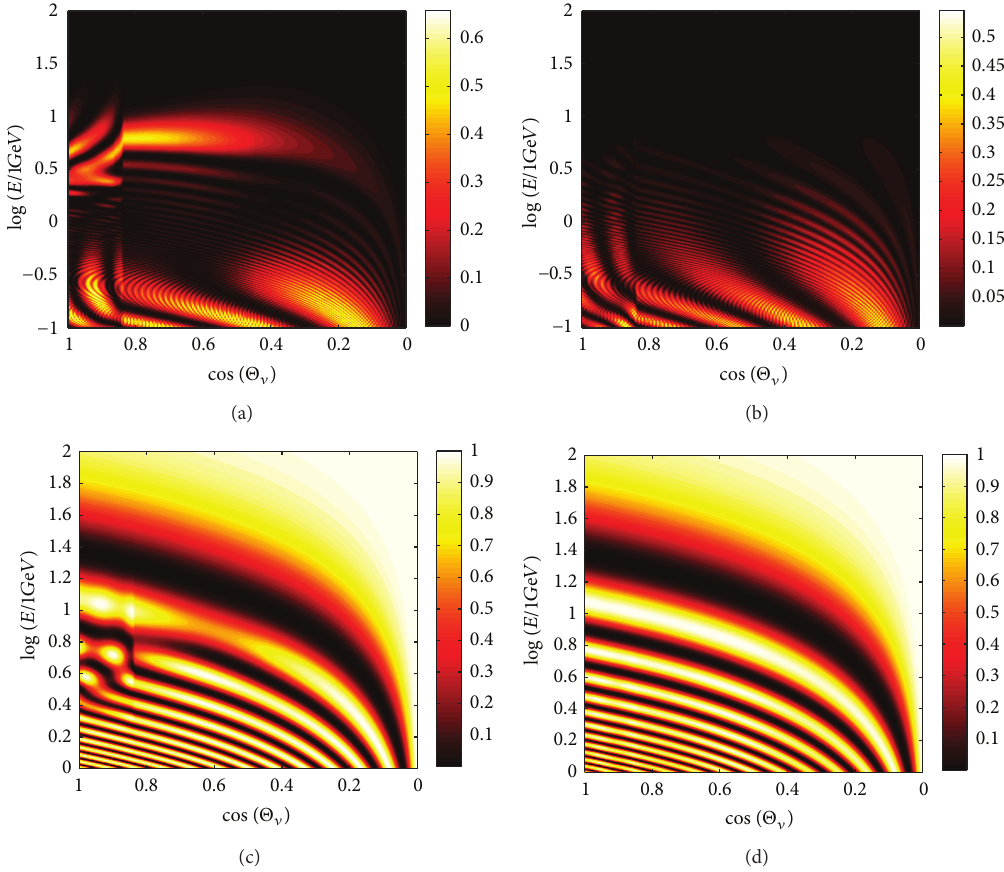
Figure 8: Neutrino oscillograms of the Earth. Shown are the lines of equal flavor conversion probability in the 𝐸 ] -cos Θ ] plane. Upper panels: → ] ] → ] ] 𝑒 𝜇 (left) and 𝑒 𝜇 (right); bottom panels: